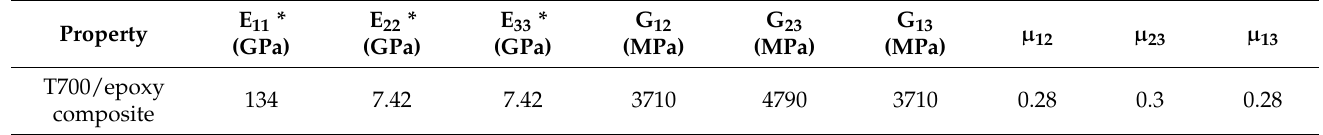
Table 5. Material properties of the T700/epoxy composite. Property